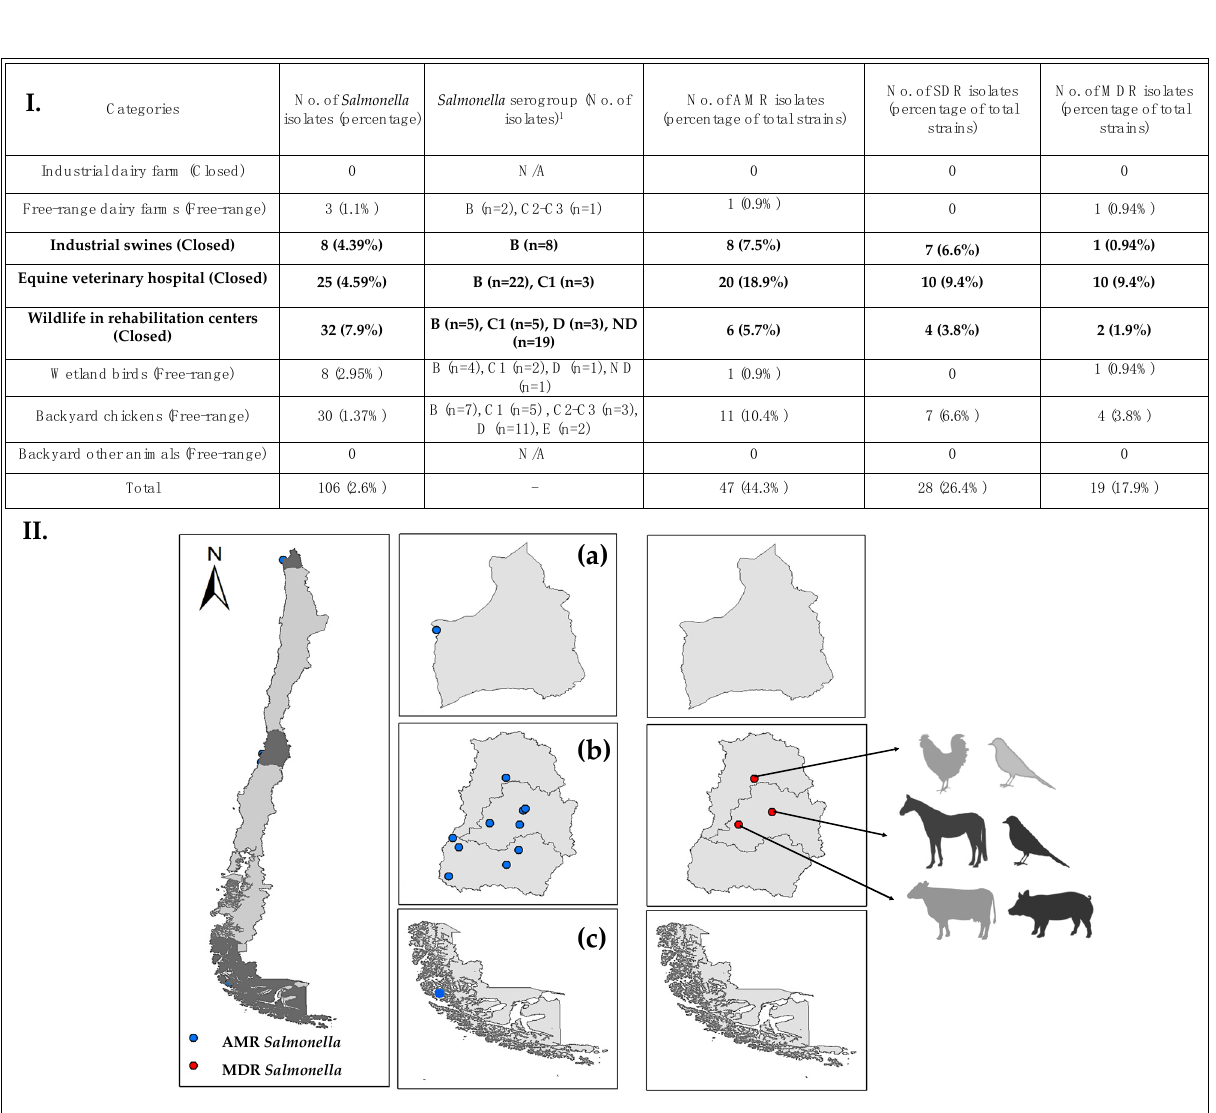
Figure 1. ( I ) Study sites of Salmonella enterica isolation from each animal system by categories. Animals from closed systems are shown in black and free-range systems in gray. 1 Serogroups were predicted using a molecular scheme. ND: Not determined. AMR stands for antimicrobial-resistance. SDR is AMR to at least one antimicrobial, and MDR means multi-resistant (to three or more antimicrobials). ( II ) Risk maps were constructed using ArcGIS 10 software (Esri, Redlands, CA, USA). ( a ) Northern sites included Region Arica y Parinacota; ( b ) Central zone is represented by Region de Valpara í so, Region Metropolitana and Region Libertador General Bernardo O`Higgins; ( c ) Southern sites are represented by Region Magallanes y Antarctica chilena. Blue circles represent the isolation sites for AMR, while red circles indicate MDR strains.